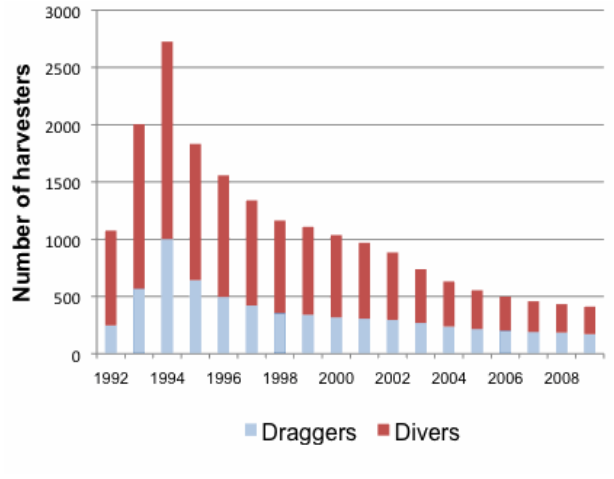
Fig. 3 . Numbers and types of sea urchin harvesters